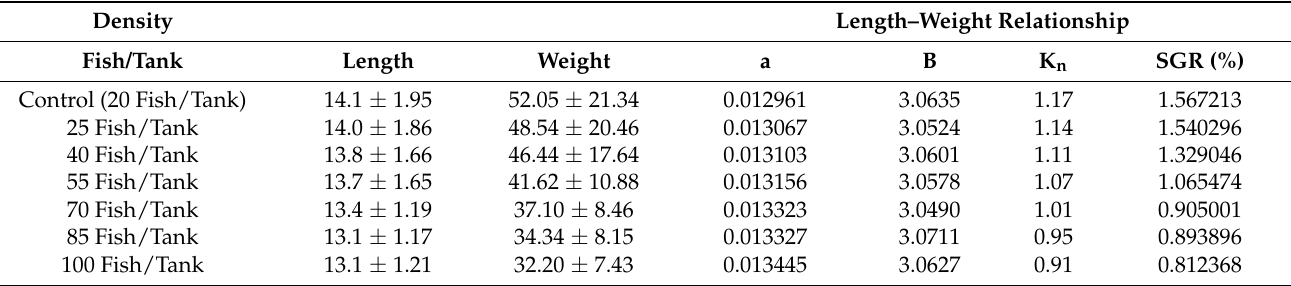
Table 3. Mean length and weight relative condition factors and specific growth rates for Nile tilapia subjected to stocking density